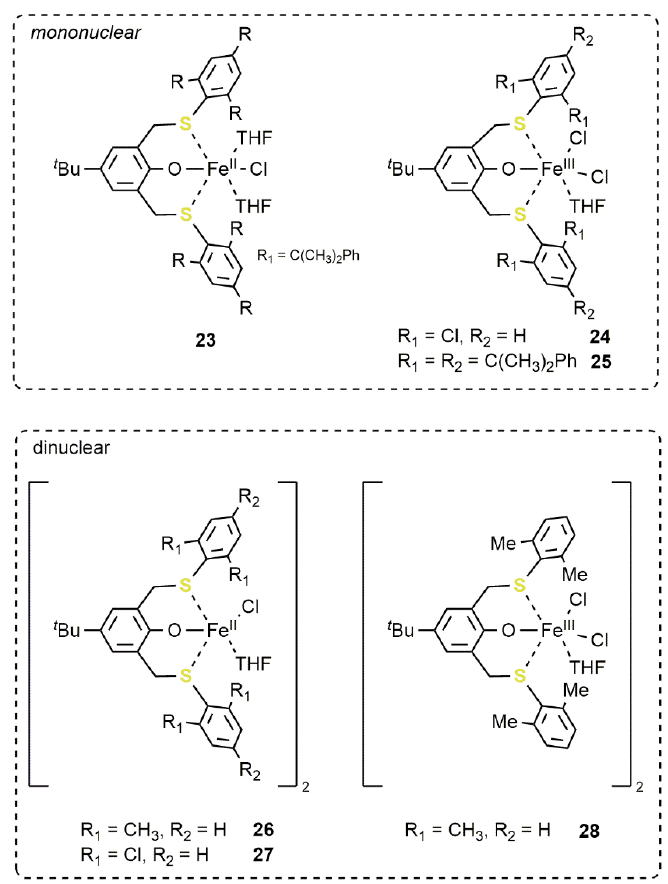
Figure 18. Bisthioether phenolate Fe(II) and Fe(III) complexes 23 – 28 [71].